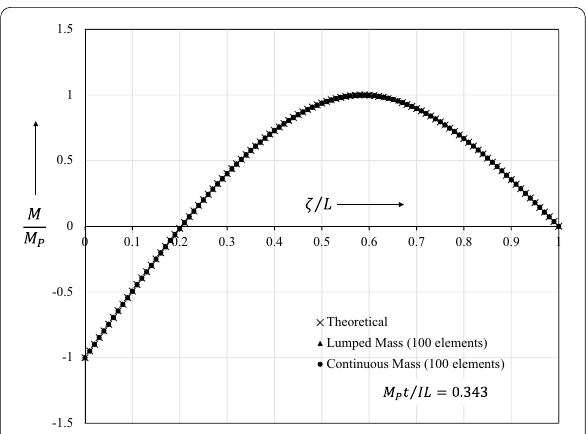
Fig. 12 Distribution of transverse velocity during Phase 1 of motion.